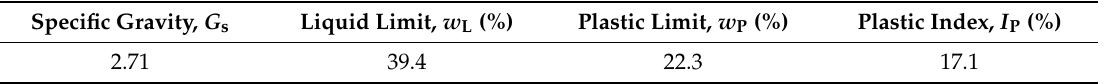
Table 1. Physical properties of soils.